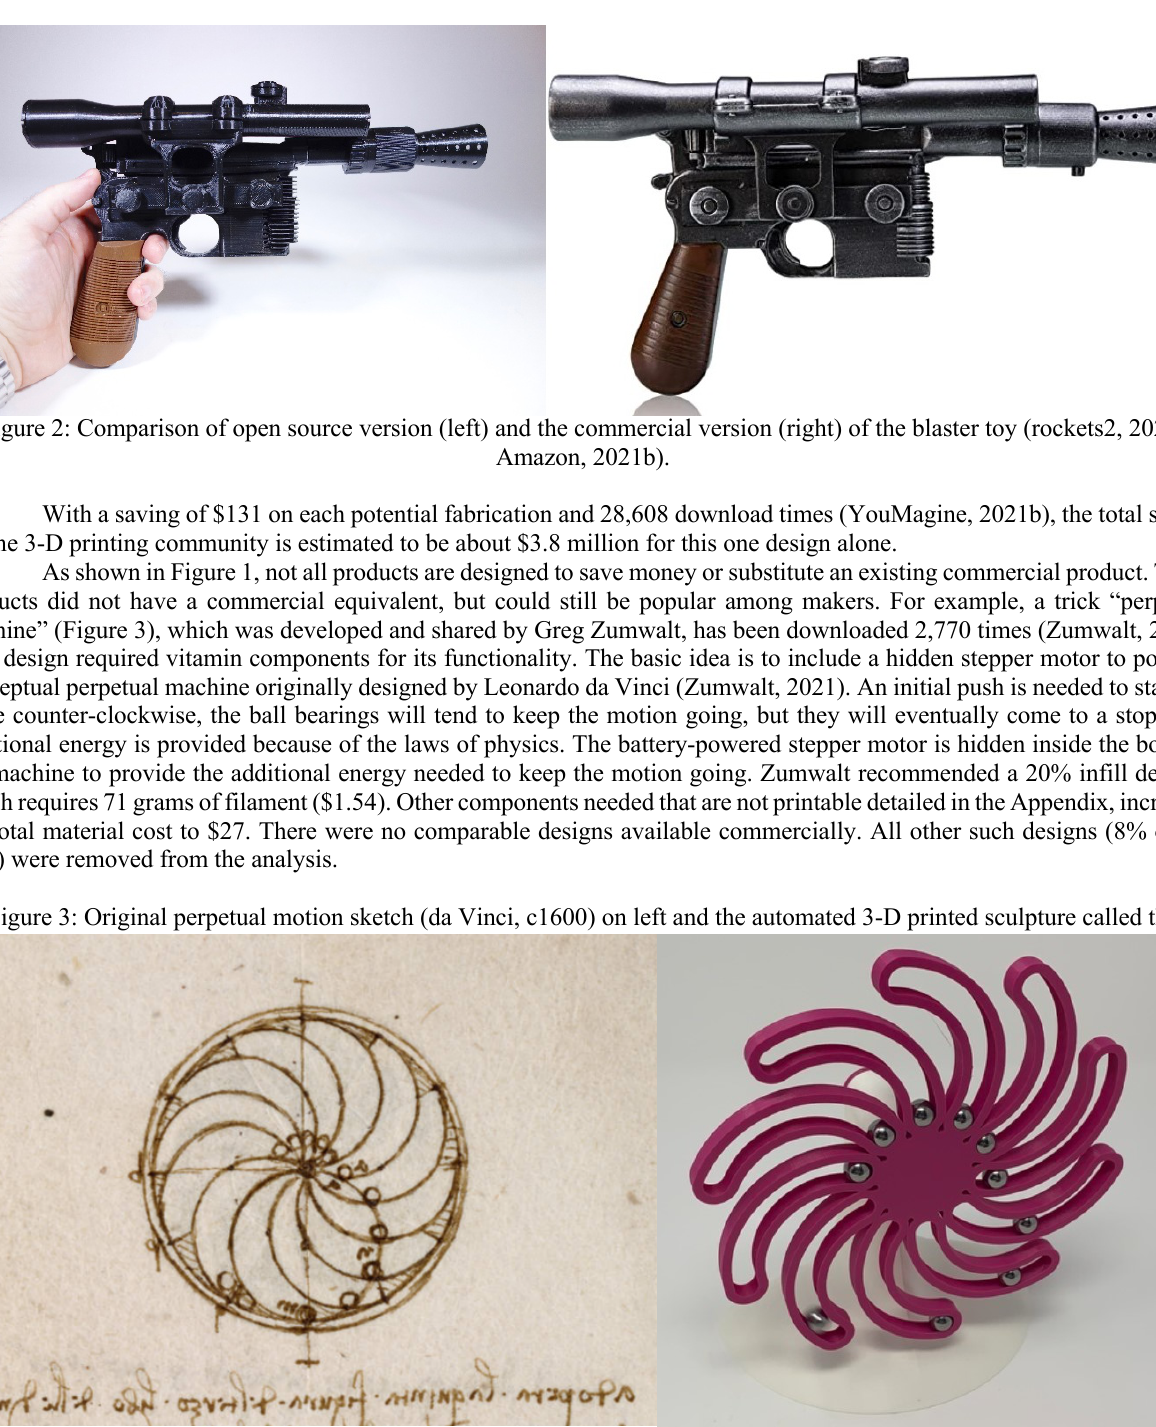
Perpetual Motion da Vinci Style II (right) (Zumwalt,